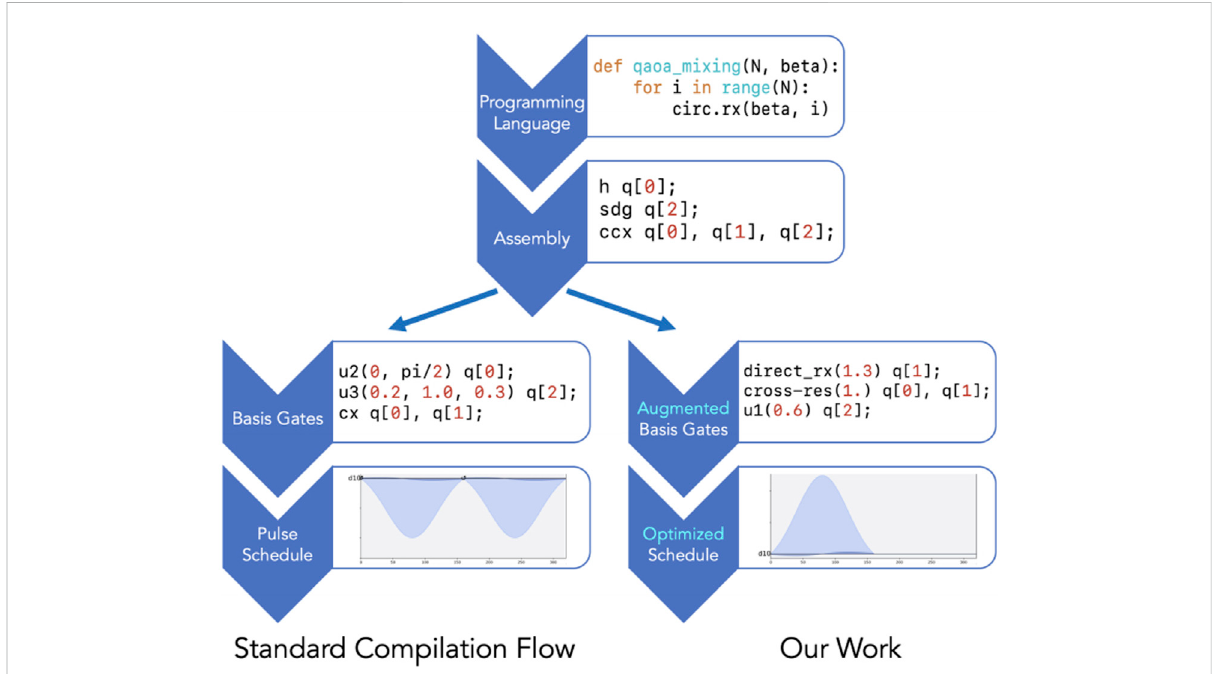
FIGURE 6 Like classical programs, quantum programs undergo a compilation process from high-level programming language to assembly. However, unlike theclassical setting, quantum hardware iscontrolled viaanalogpulses. This work optimizesthe underlying pulse schedule by augmenting the set basis gates to match hardware. The compiler automatically optimizes user code, which therefore remains hardware-agnostic.